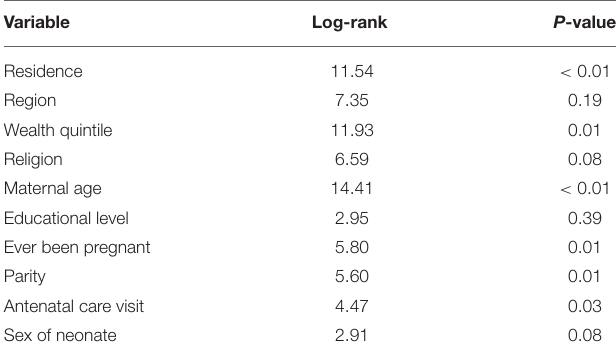
TABLE 2 | Result of log-rank test for neonates born to Ethiopian women, October 2019 to September 2020 ( n =